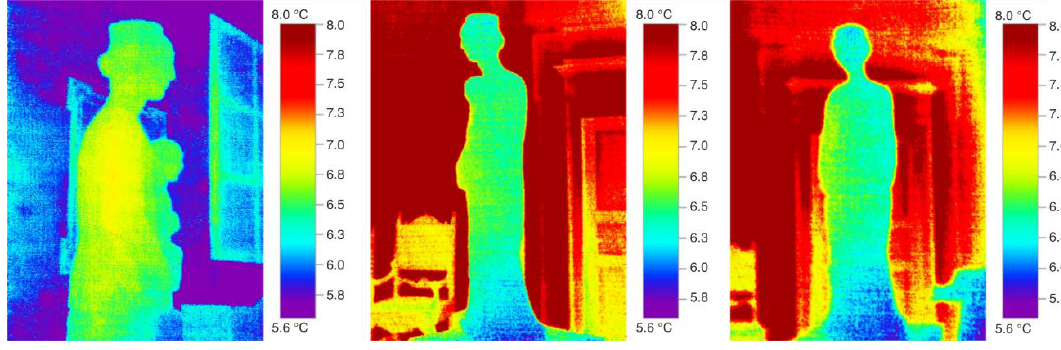
Figure 16. Three thermograms of the statue, acquired from different poses.